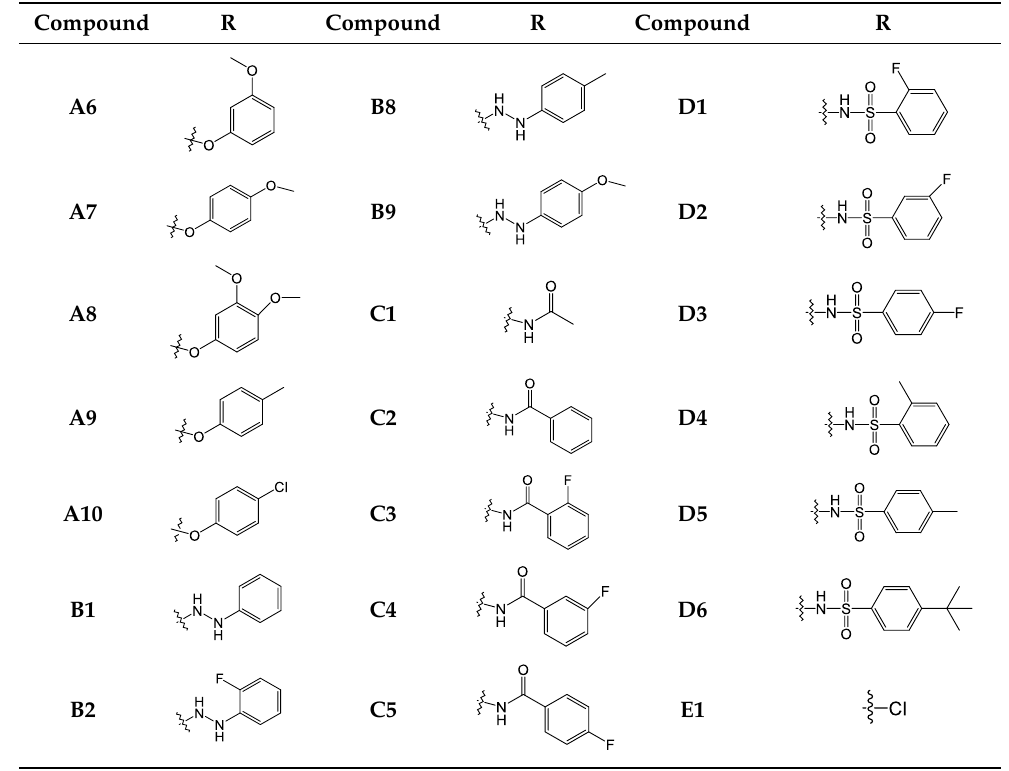
Table 5. Antiproliferative activities (IC 50 , μM) of compounds D1-D6 and E1 on SMMC7721 and AGS cells for 48 h.